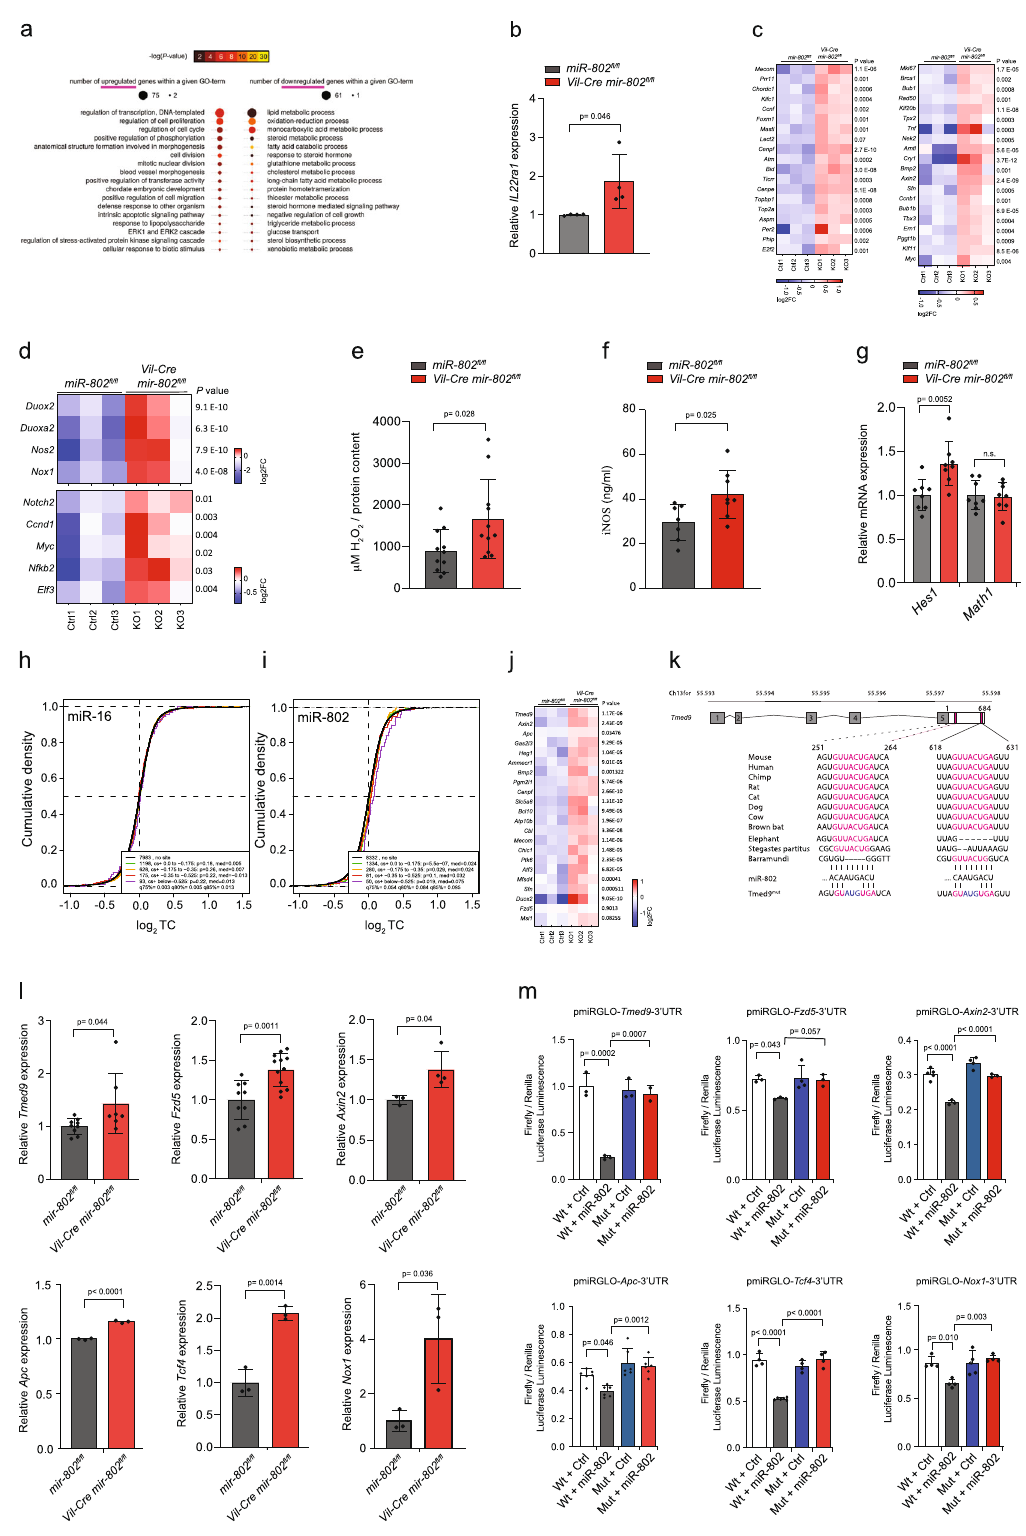
eceptor Fzd5 , two members of the β -catenin destruction complex ( Axin2 and Apc ), Tcf4 a downstream target of Wnt signaling, and the NADPH oxidase1 ( Nox1 ) (Fig. 4l). To test whether the predicted miR-802 target sites in the 3 ′ UTR of Tmed9 , Fzd5 , Axin2 , Apc , Tcf4 , and Nox1 mRNA were responsible for their derepression in the absence of miR-802 , we cloned their putative 3 ′ UTRs downstream of a luciferase reporter gene and co-